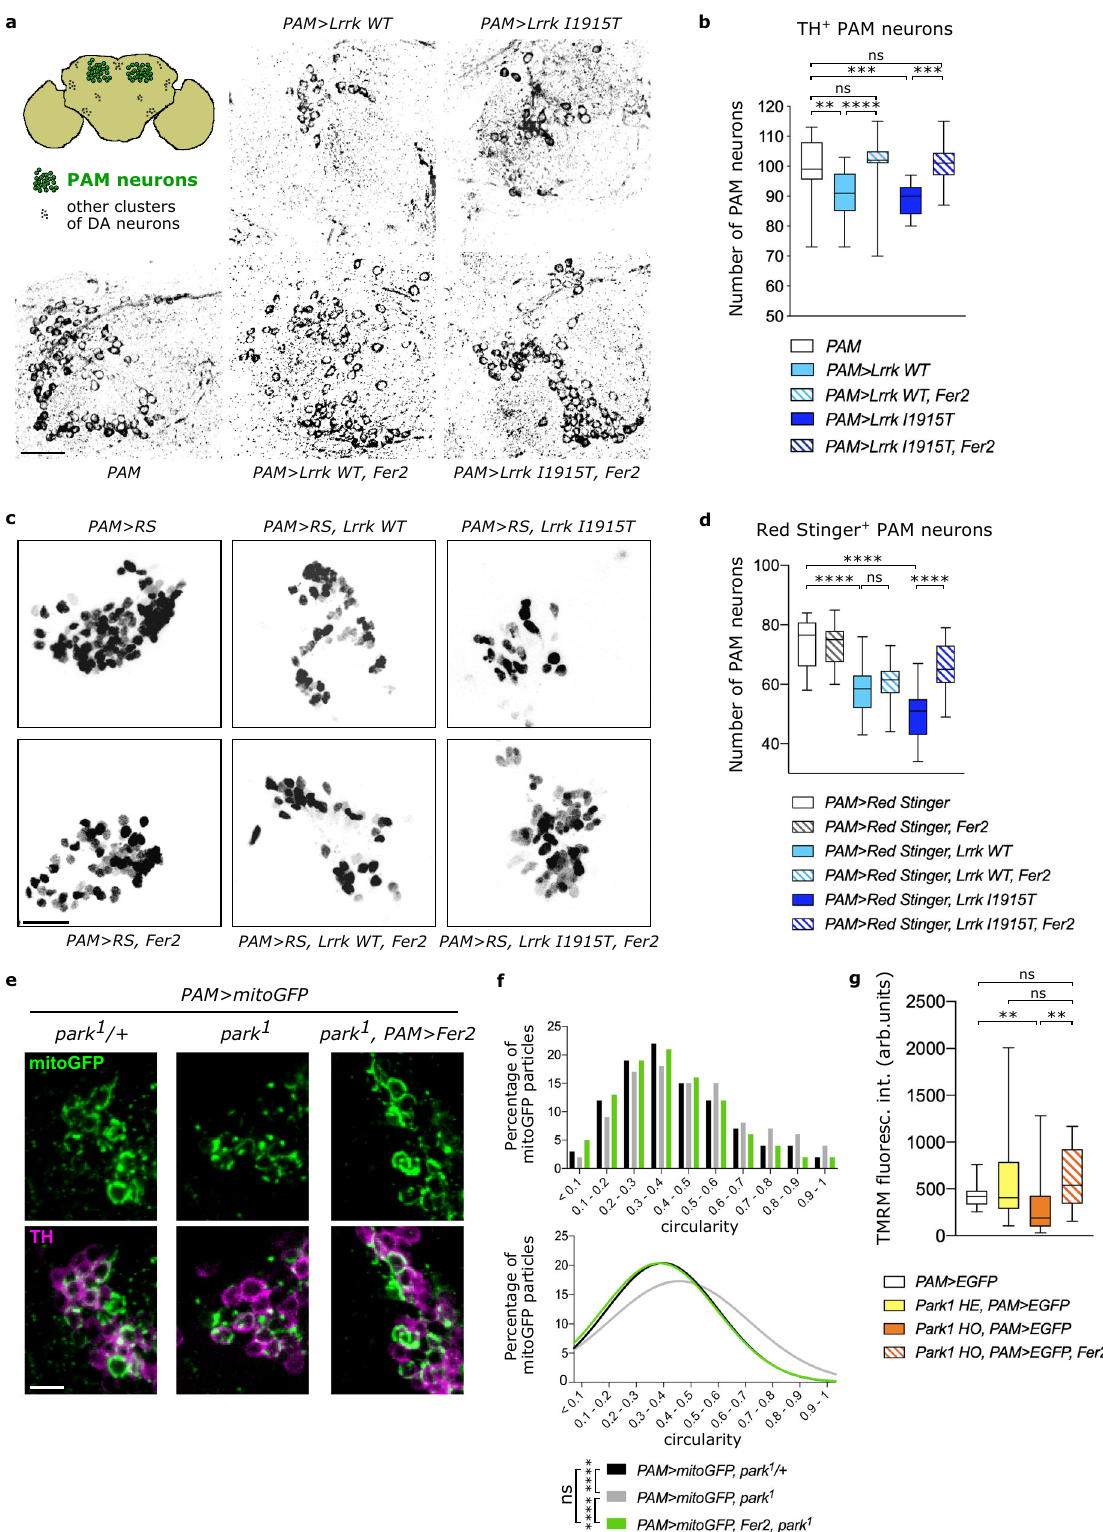
Therefore, Lrrk gain of function causes not only developmental loss but also age-dependent loss of PAM neurons. Remarkably, overexpression of Fer2 in PAM neurons prevented the reduction of TH-positive cell counts induced by the expression of wild-type or mutant Lrrk (Fig. 1a, b). The analysis of cell counts using RedStinger found that PAM neuron loss caused by the